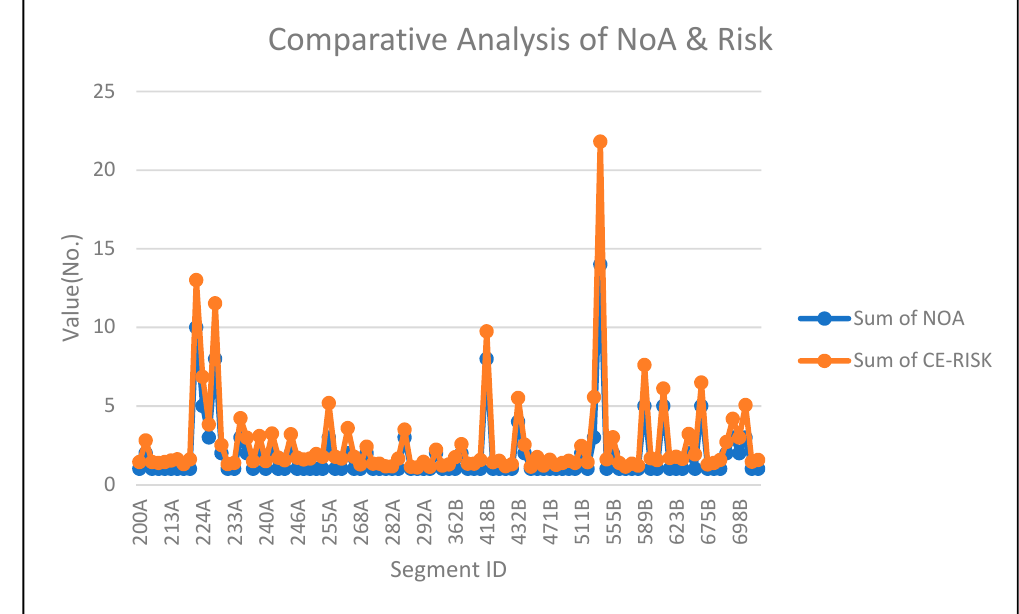
Figure 7. Comparative analysis of number of accidents and risk index.